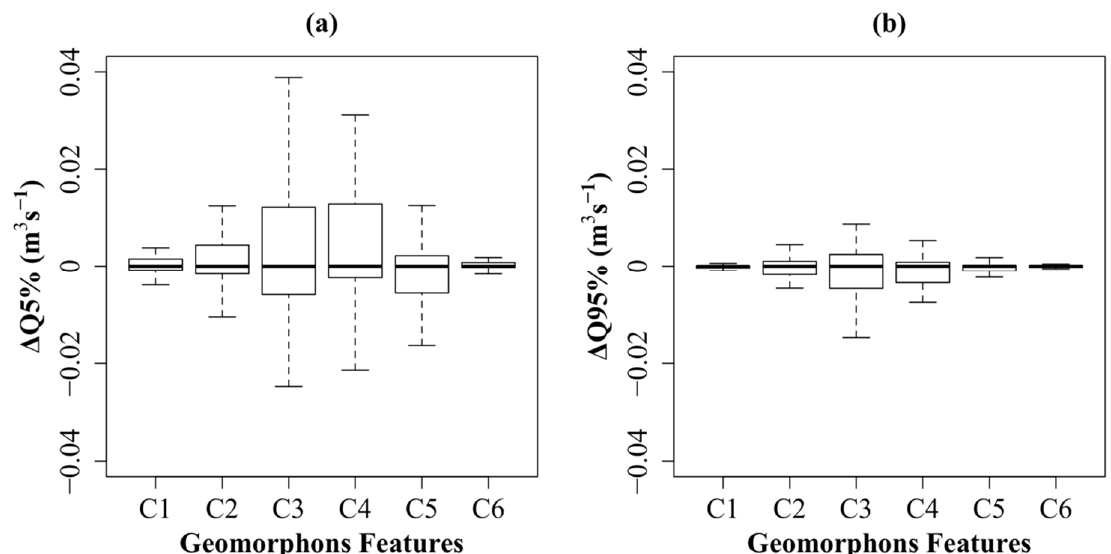
Figure 6. Variation of Q5% ( a ) and Q95% ( b ) in m 3 s − 1 for daily streamflow simulated during sensitivity analysis from parameter perturbations, separated by Geomorphons feature (C1: ridge, C2: spur, C3: slope, C4: hollow, C5: valley, C6: pit).